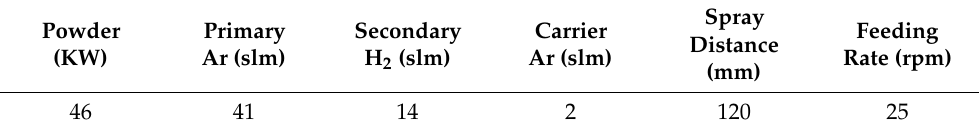
Table 2. Operating parameters used for air plasma